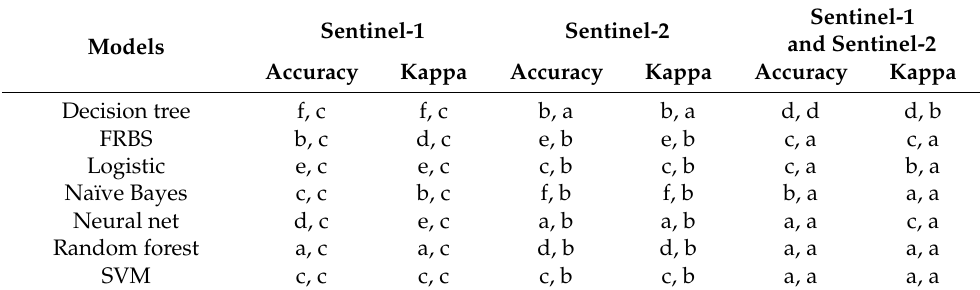
Table 3. Pair-wise test for accuracy and kappa